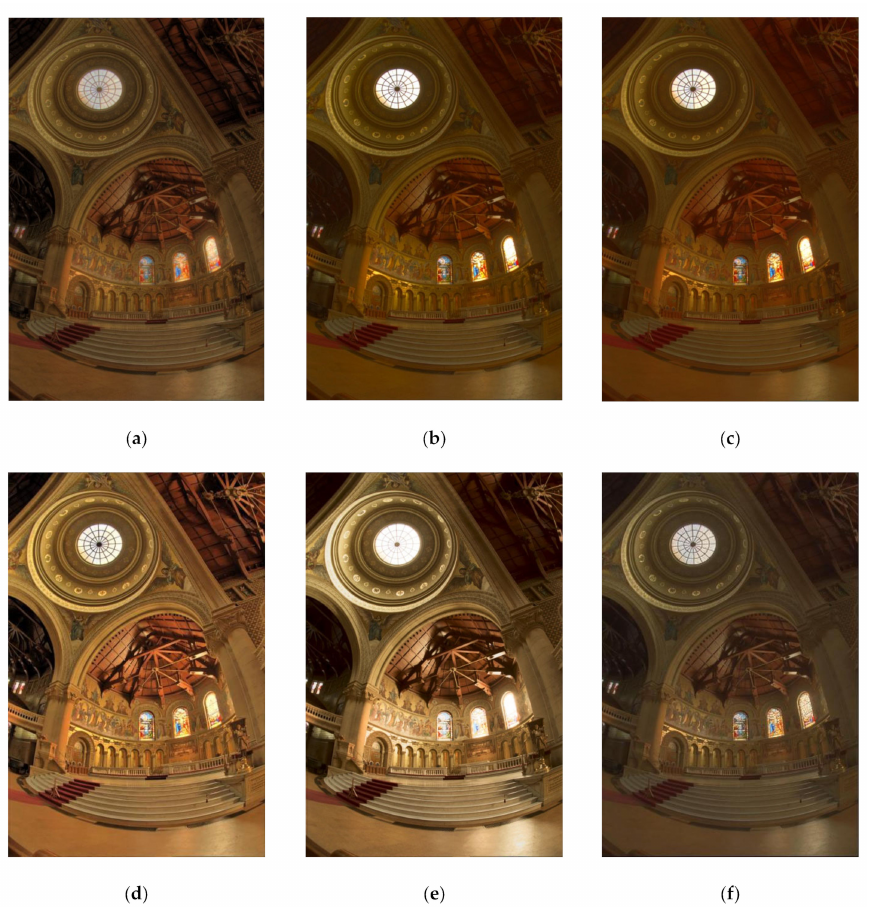
Figure 7. A comparison of tone mapping algorithms on the memorial church image. ( a ) Result by TMO-Net. ( b ) Result by DeepTMO. ( c ) Result by Thai. ( d ) Result by L1-L0. ( e ) Result by Khan. ( f ) Result by our algorithm.